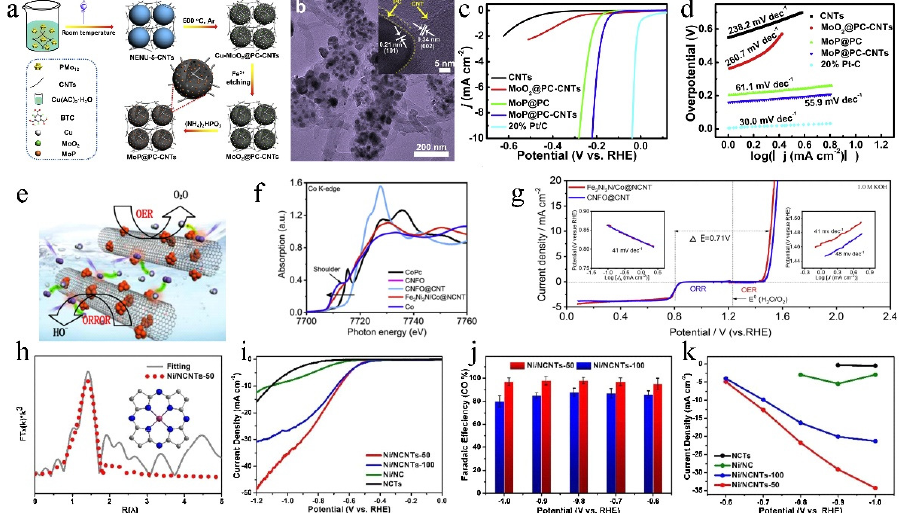
Figure 8. ( a ) Schematic illustration of the fabrication of MoP@PC-CNTs nanocomposite. ( b ) TEM images of MoP@PC-CNTs. ( c ) HER LSV curves of different catalysts and ( d ) the corresponding HER Tafel plots. Reproduced with permission [93]. Copyright 2018, Elsevier Ltd. ( e ) Illustration of ORR and OER on Fe 2 Ni 2 N/Co@NCNT. ( f ) Co K-edge XANES and spectra of various catalysts and standard samples, including FePc (Iron (II) phthalocyanine), CoPc (Cobalt (II) phthalocyanine) and NiPc (Nickle (II) phthalocyanine). ( g ) LSV curves for ORR and OER of Fe 2 Ni 2 N/Co@NCNT in O 2 -saturated 1.0 M KOH at a scan rate of 5 mV s − 1 , with the inset showing ORR ( left ) and OER ( right ) Tafel plots of the Fe 2 Ni 2 N/Co@NCNT. Reproduced with permission [94]. Copyright 2019, Elsevier Ltd. ( h ) The corresponding EXAFS fitting curves of Ni/NCTs-50. ( i ) LSV curves, ( j ) FE CO and ( k ) CO partial current densities for Ni/NCTs-50, Ni/NCTs-100, Ni/NC and NCTs in CO 2 -saturated 0.5 M KHCO 3 solution at various applied potentials. Reproduced with permission [95]. Copyright 2020,